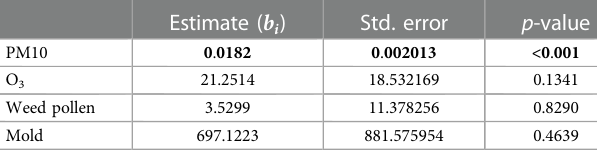
TABLE 4 A multiple linear regression analysis of the number of asthma exacerbations (t)/week (y) and correlated atmospheric substance (t) in autumn.